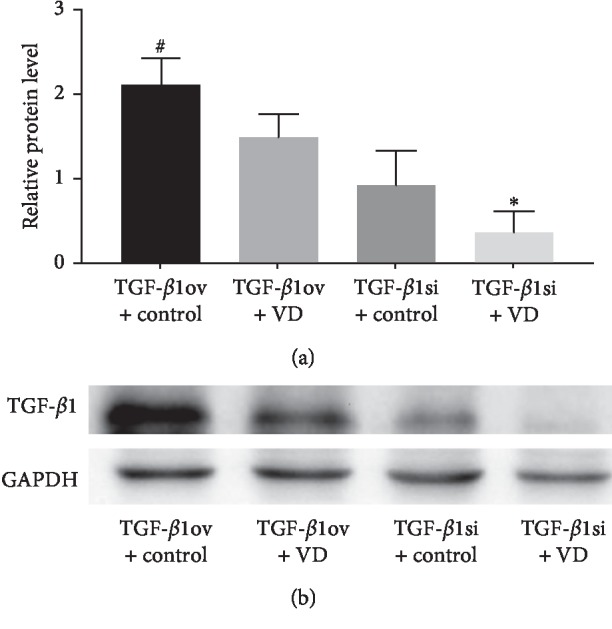
TGF-β1 protein expression. (a) Relative protein level and (b) western blotting. TGF-β1ov + control, TGF-β1 overexpression + oil; TGF-β1 ov + VD, TGF-β1 overexpression +1,25(OH)2D3; TGF-β1si + control, TGF-β1 siRNA + oil; TGF-β1si + VD, TGF-β1 siRNA + 1,25(OH)2D3. ∗p < 0.05 vs TGF-β1si + control; #p < 0.05 vs TGF-β1ov + VD.